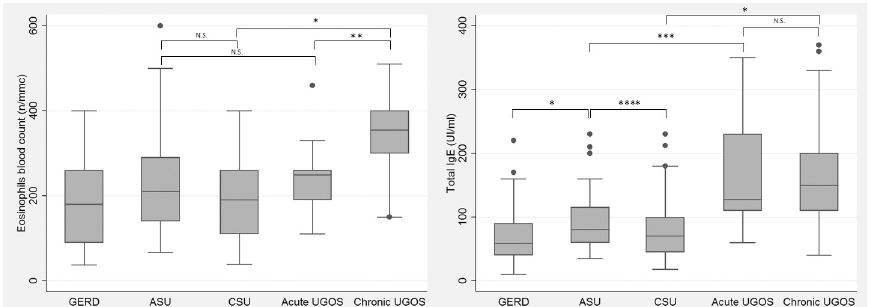
Fig 1. Blood eosinophils and total IgE levels, according to different clinical presentations of gastroesophageal reflux disease (GERD) and/or urticaria. Eosinophils and total IgE are significantly more elevated in all cases of urticaria and GERD overlap syndrome (UGOS) compared to isolated cases of GERD or urticaria. To be noted in the figure, where some of the significant differences are highlighted, how both values show a stepwise increase from the isolated GERD group up to the chronic urticaria and GERD overlap syndrome (Chronic UGOS) group. � : p < 0.00001; �� : p = 0.0018; ��� : p = 0.003; ���� : p = 0.028; N.S. = Not